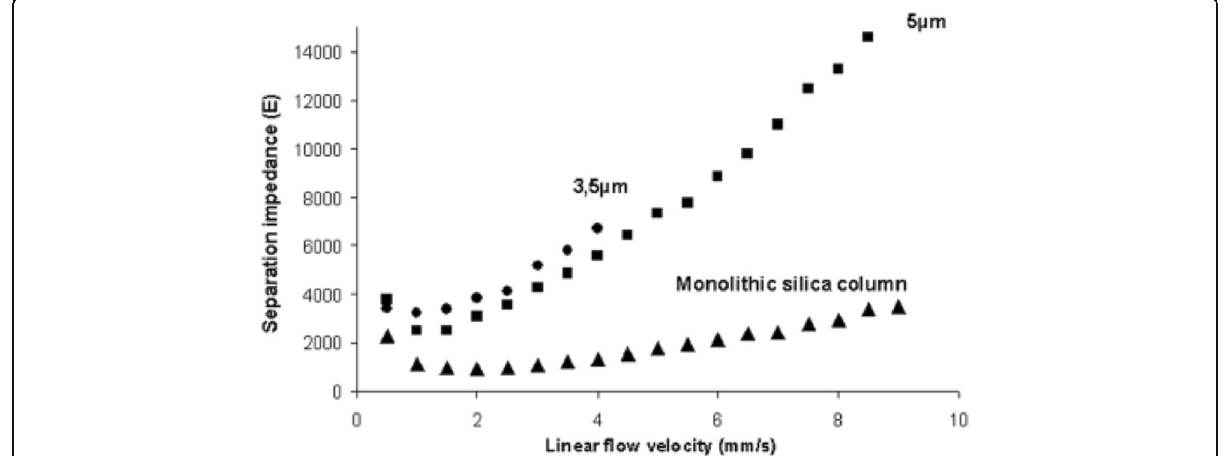
Fig. 5 Separation impedance for the conventional and monolithic column. Lesser the separation impedance better is the separation (Cabrera,